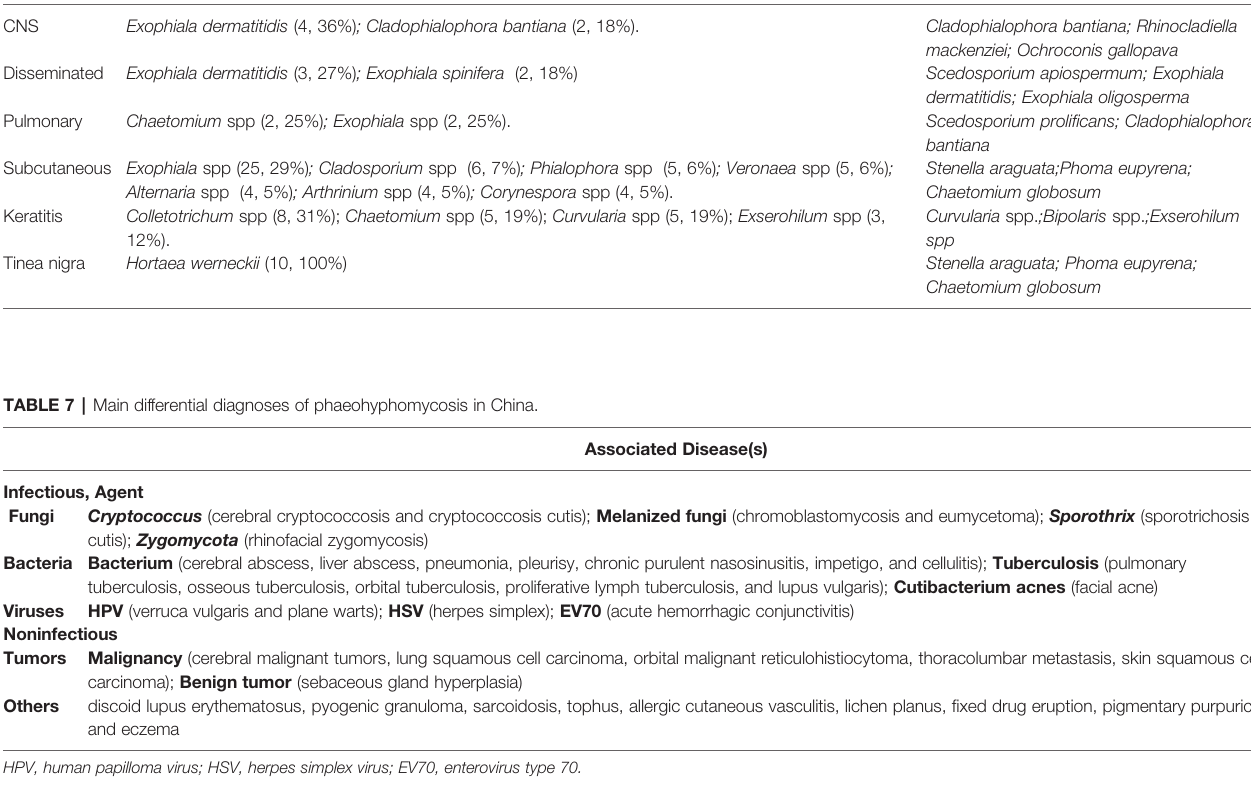
TABLE 6 | The differences in strains in PHM between China and foreign countries. Infection Types